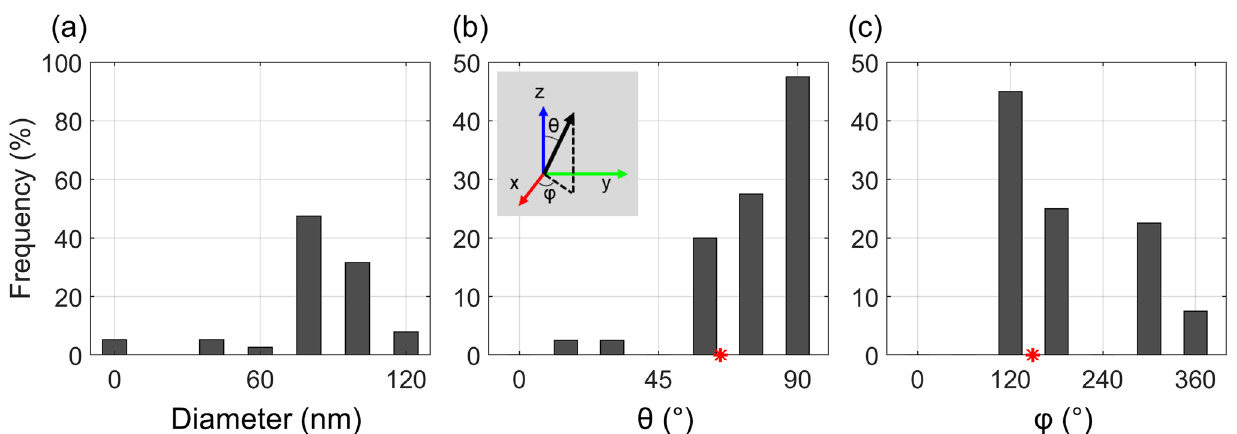
Figure 4. Histograms for the distribution of ( a ) diameter and ( b,c ) orientation of collagen fibers for the same location as in Fig. 3d on a right leaflet at 20 mmHg. Fibers detected using XFiber show a narrow distribution of diameters between 80–100 nm, and close alignment along the circumferential direction of the leaflet (red star). θ represents the angular deviation of a fiber with the z-axis and φ is azimuthal angle in the xy-plane with the x-axis (insert) . All axes refer to the coordinate system of the SEM data as is shown in Fig. 3a. The circumferential direction is drawn from the NURBS-fitted surface at the SEM location (θ = 65°, φ =